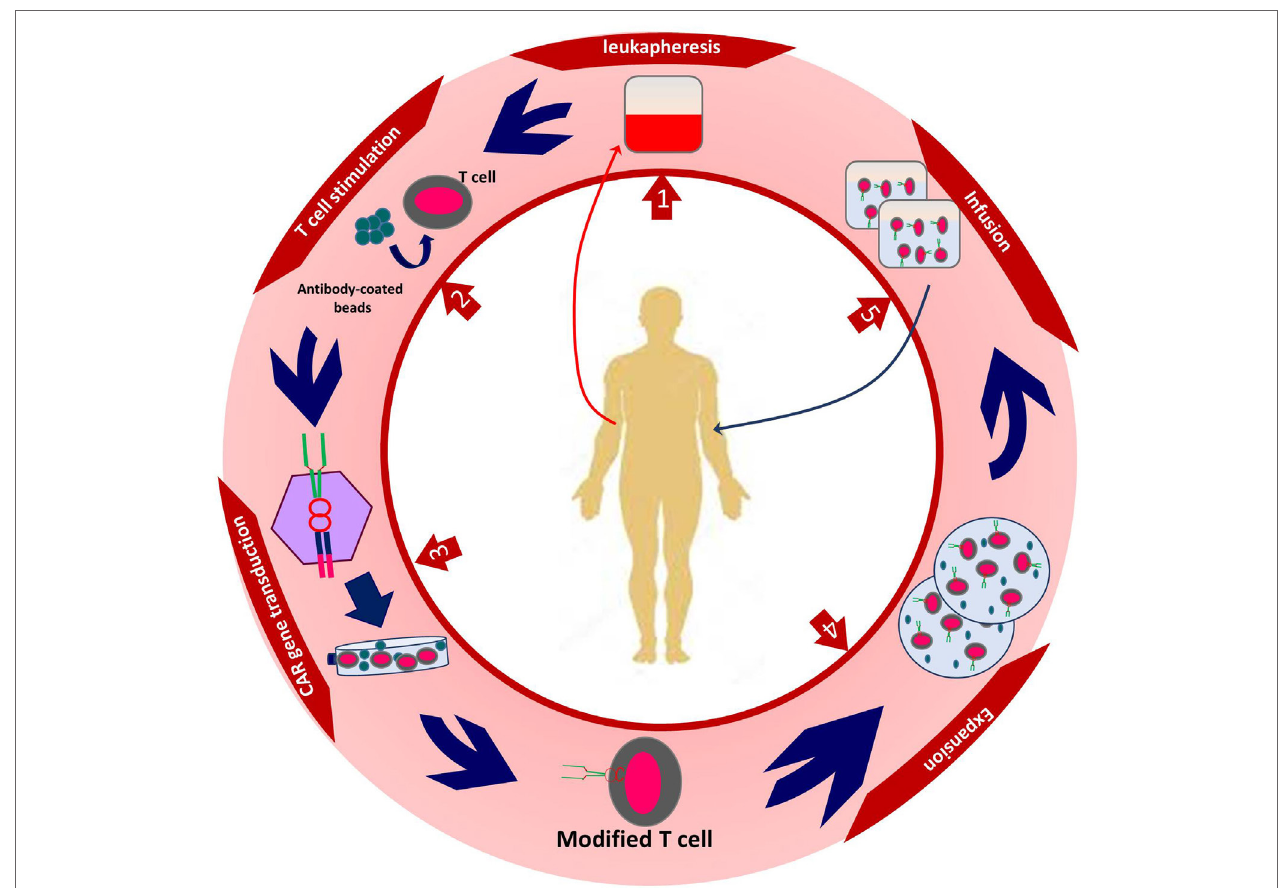
FiGURe 2 | The procedure of autologous chimeric antigen receptor (CAR) T cell production. Created by Esmaeilzadeh et